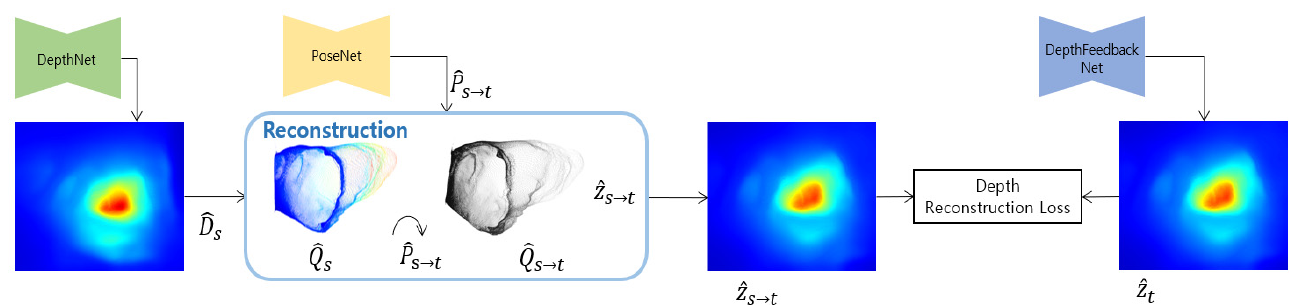
Figure 5. View synthesis structure for depth reconstruction. Similar to image reconstruction, the depth of source is reconstructed and transformed. ˆ z s → t is extracted from the reconstructed ˆ Q s → t for depth reconstruction loss. Finally, the loss between ˆ z s → t and ˆ z t is